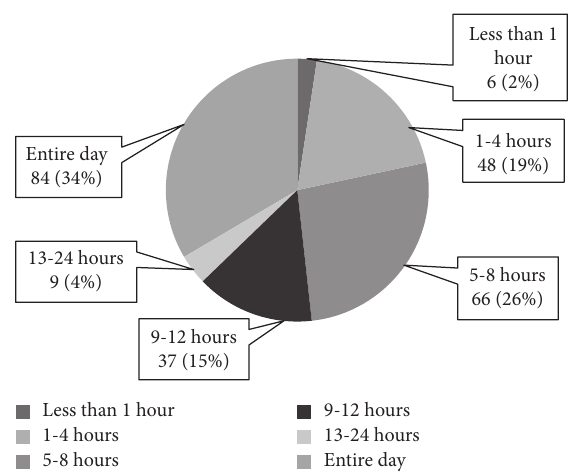
Figure 3: Discrete distribution of AV time availability ( n �